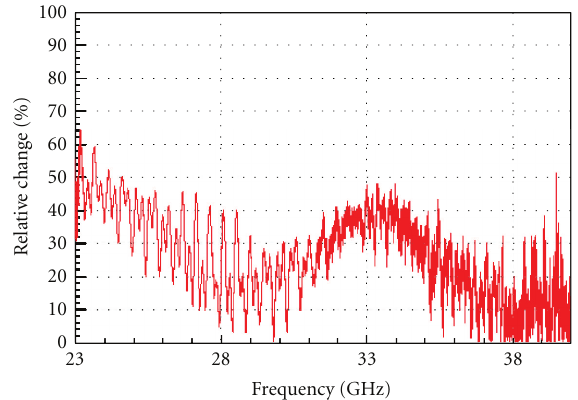
Figure 5: Relative percent change of ammonia-water sample with reference to water-only sample.